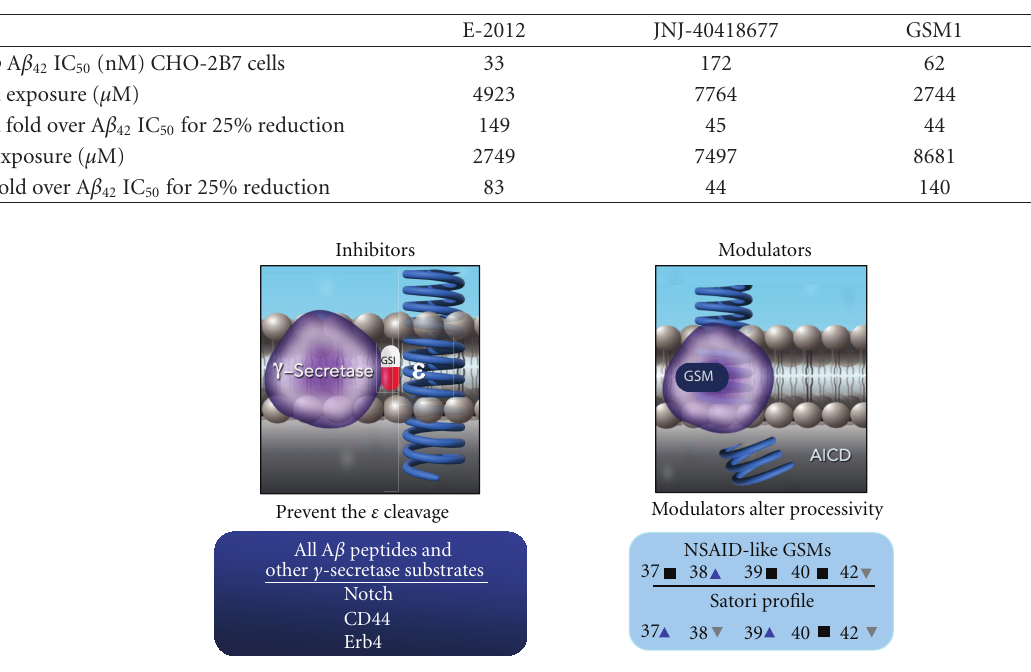
Figure 7: Diagram highlighting the di ff erences between inhibitors and